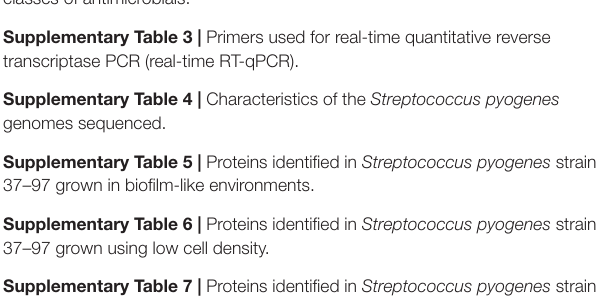
Supplementary Table 2 | Characteristics of the Streptococcus pyogenes strains selected as controls for the experiments of persister generation for different classes of